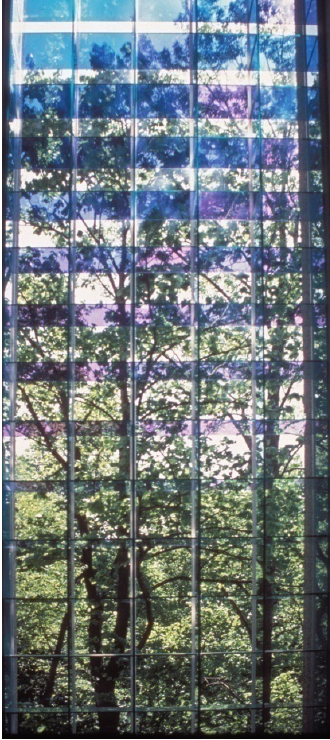
Figure 11: view through the Structural Glass Prisms.